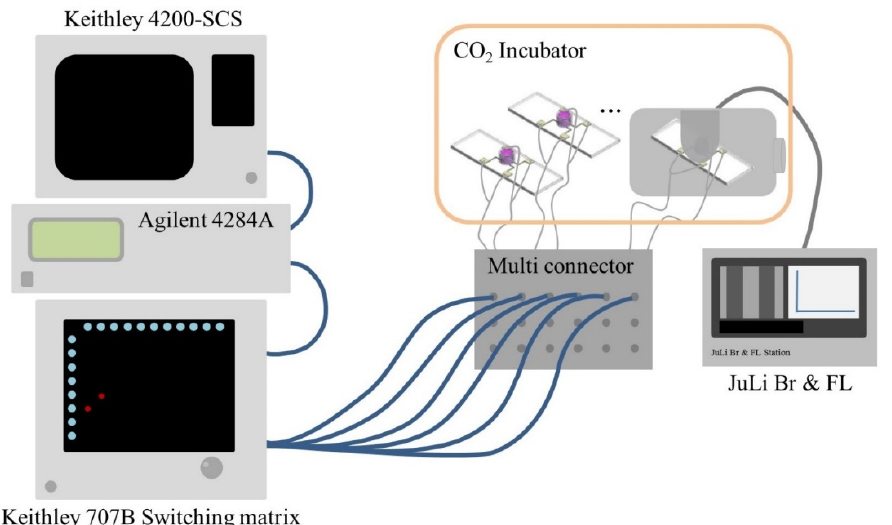
Figure 2. Cell measuring process on the biosensor.